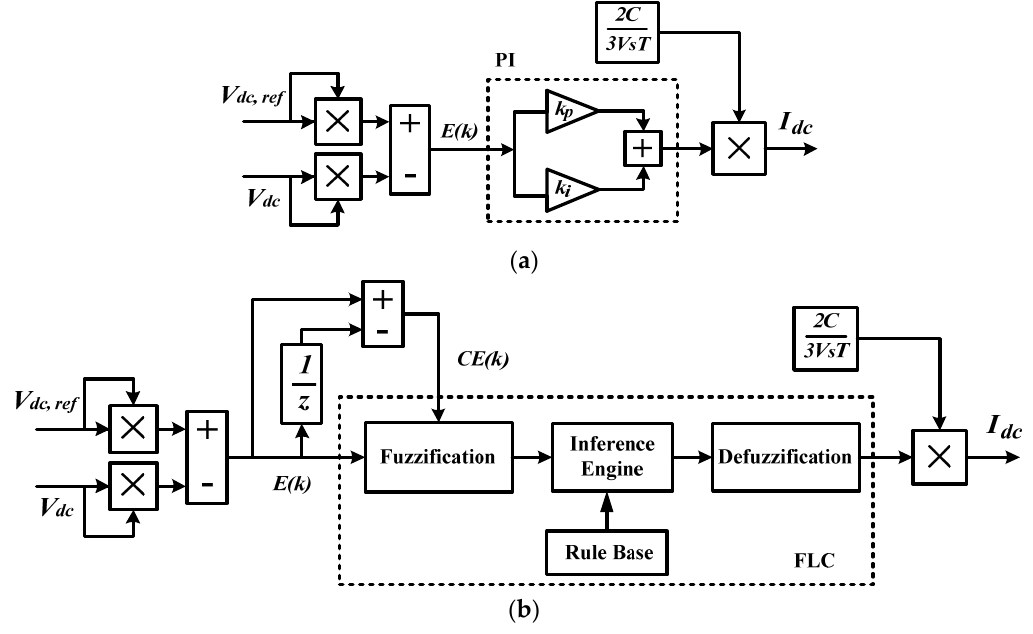
Figure 7. Control structure of self-charging with the ( a ) PI and ( b ) FLC techniques [41,57].